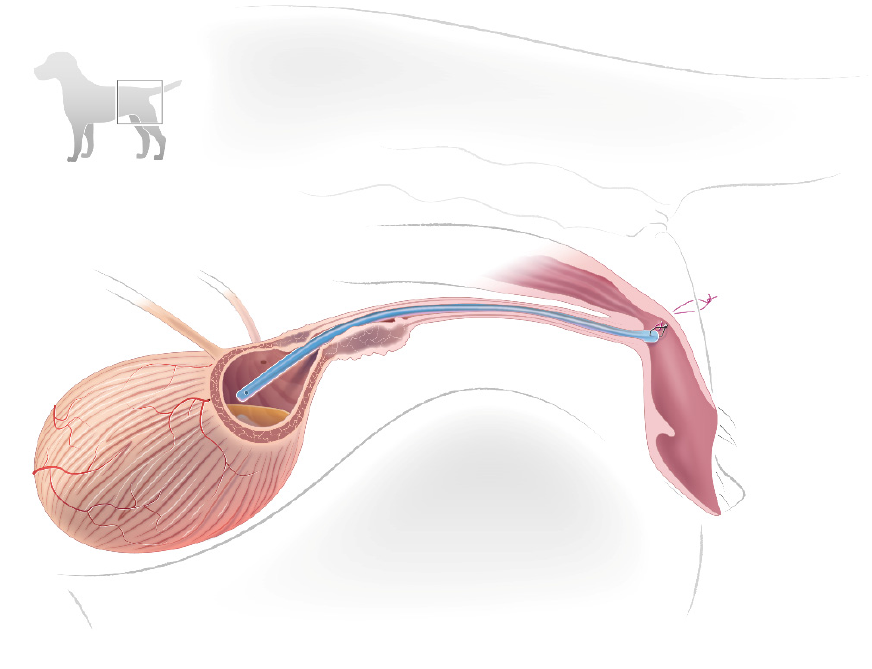
Figure 2. Illustration of a temporary stent placed in the urethra of a female dog. The proximal tip of the stent is placed cranial to the obstructing urethral lesion. The distal tip of the stent is anchored to the inside wall of the vestibule with a loop of suture loosely tied over perineal skin near the vulva. The square in the upper insert identifies the location of interest in the dog. © Diogo Guerra.